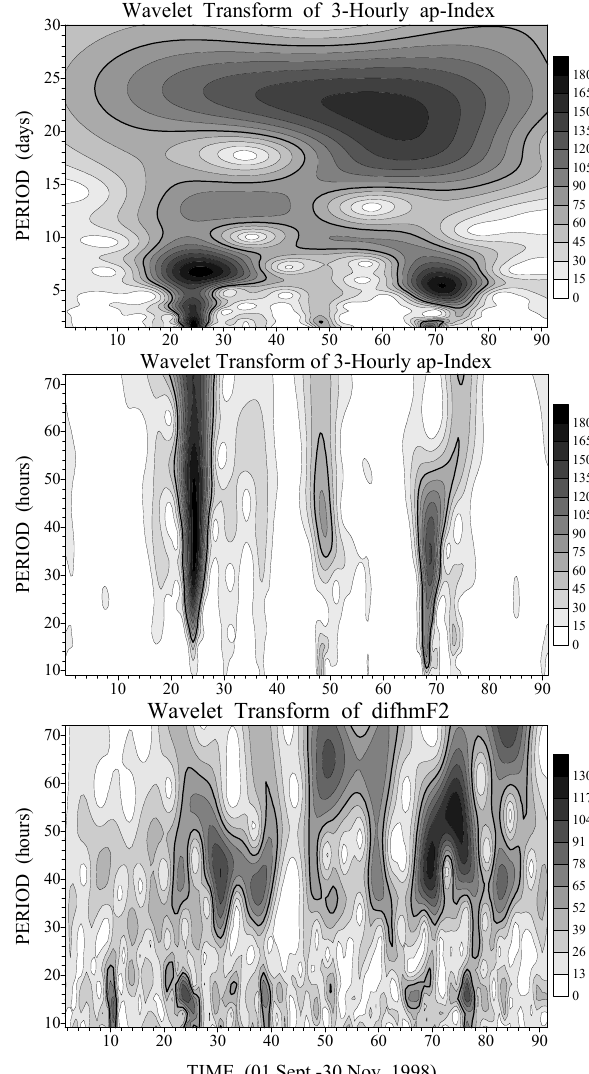
Fig. 11. Wavelet transform of the geomagnetic A p -index in the period range 1.5–30days (upper plot), the wavelet transform of the same parameter, but in the period range 8–72h (middle) and wavelet transform of the difference between the hourly data and the ref- erence diurnal course of the hm F2 (residual of hm F2) in the pe- riod range 8–72h (bottom) for the time interval 1 September – 30 November